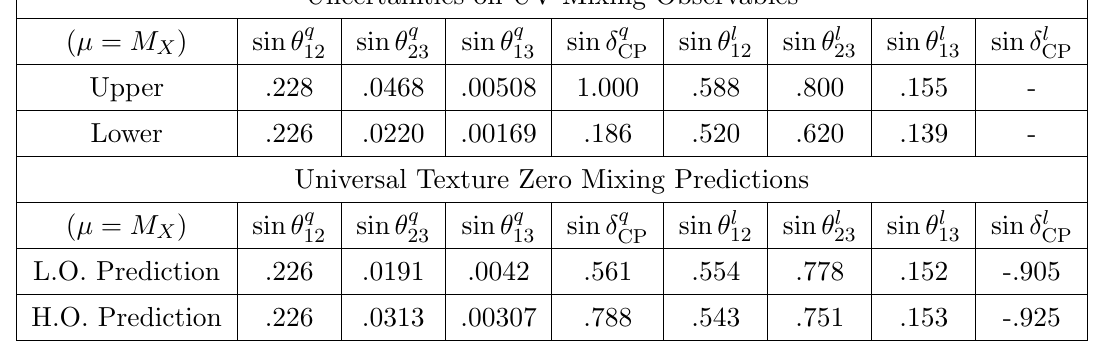
Table 4 . Top : uncertainty estimates for mixing observables in the UV. For the quarks, the upper and lower values are estimated by taking overall error bands calculated by running the observables (with propagated experimental uncertainty) at various choices of tan (cid:12) and other RGE input from [34]. We take the 3 (cid:27) global bounds from NuFit as extrema for the leptons, within which the leptonic CP violating phase is not constrained. Bottom : predictions of mixing angles and CP violating phases extracted from the lower and higher order (cid:12)ts in eq. (5.5){eq. (5.8). Our predictions are within the estimated uncertainty bounds.